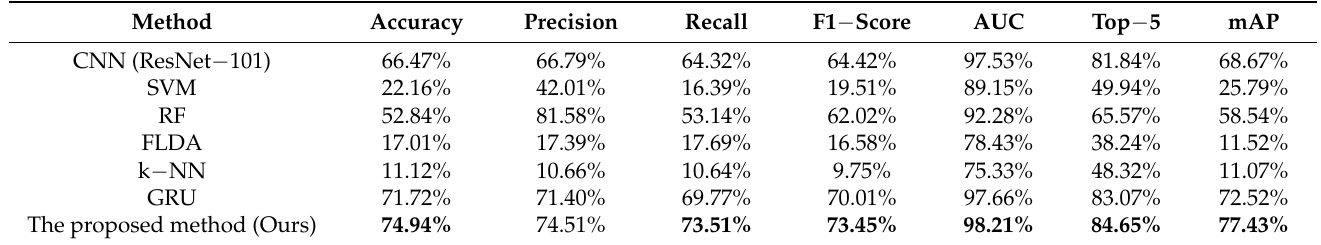
Table 4. Performance comparison between the proposed method, CNN, SVM, RF, FLDA, KNN, and GRU. The best results are shown in bold font.